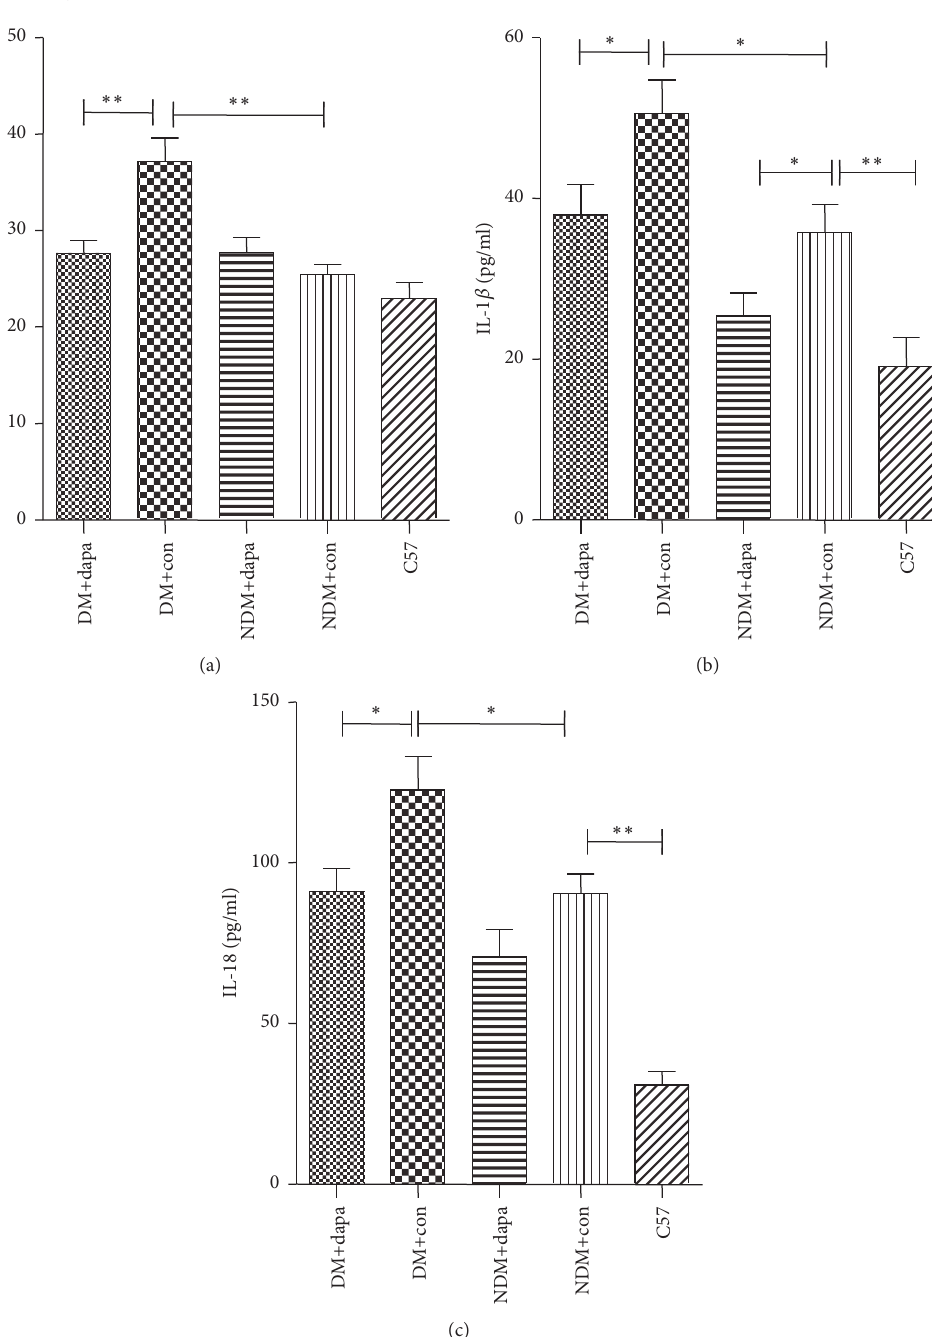
Figure 2: Changes of serum NLRP3 inflammasome, IL-1 𝛽 , and IL-18 levels in mice from each group. (a), (b), and (c) represented the serum levels of NLRP3, IL-1 𝛽 , and IL-18, respectively. After 12 weeks of treatment with dapagliflozin, the serum levels of NLRP3, IL-1 𝛽 , and IL-18 significantly reduced in DM mice. ∗ 𝑝 < 0.05 ; ∗∗ 𝑝 < 0.01